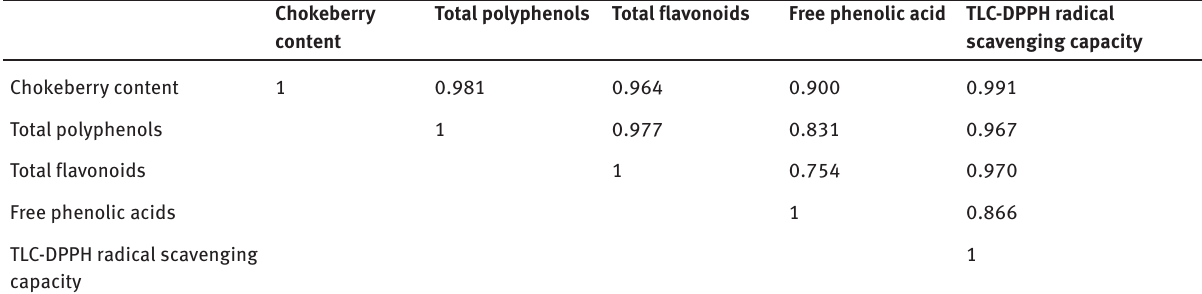
Table 5: Pearson correlation coefficient; p <0,05.